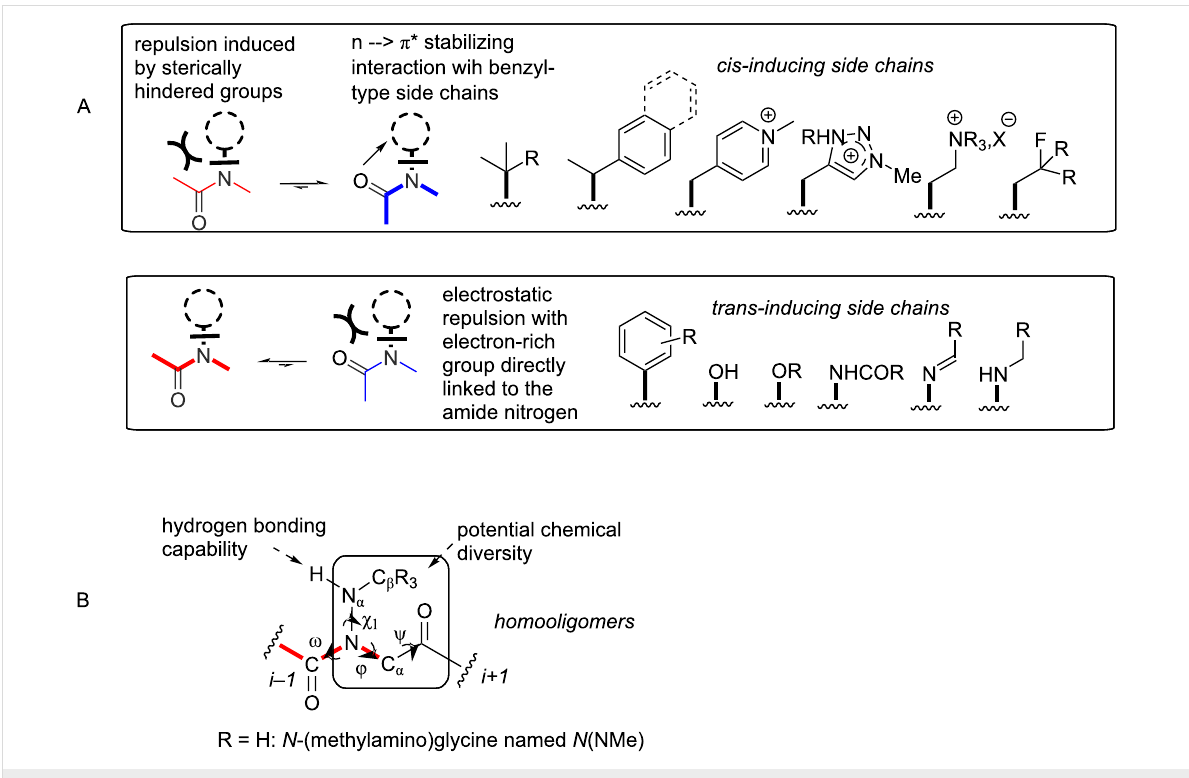
Figure 1: (A) Summary of the main side chains exerting significant steric and/or electronic effects and influencing the amide conformation of peptoids. (B) Atom labels in N -(methylamino)glycine